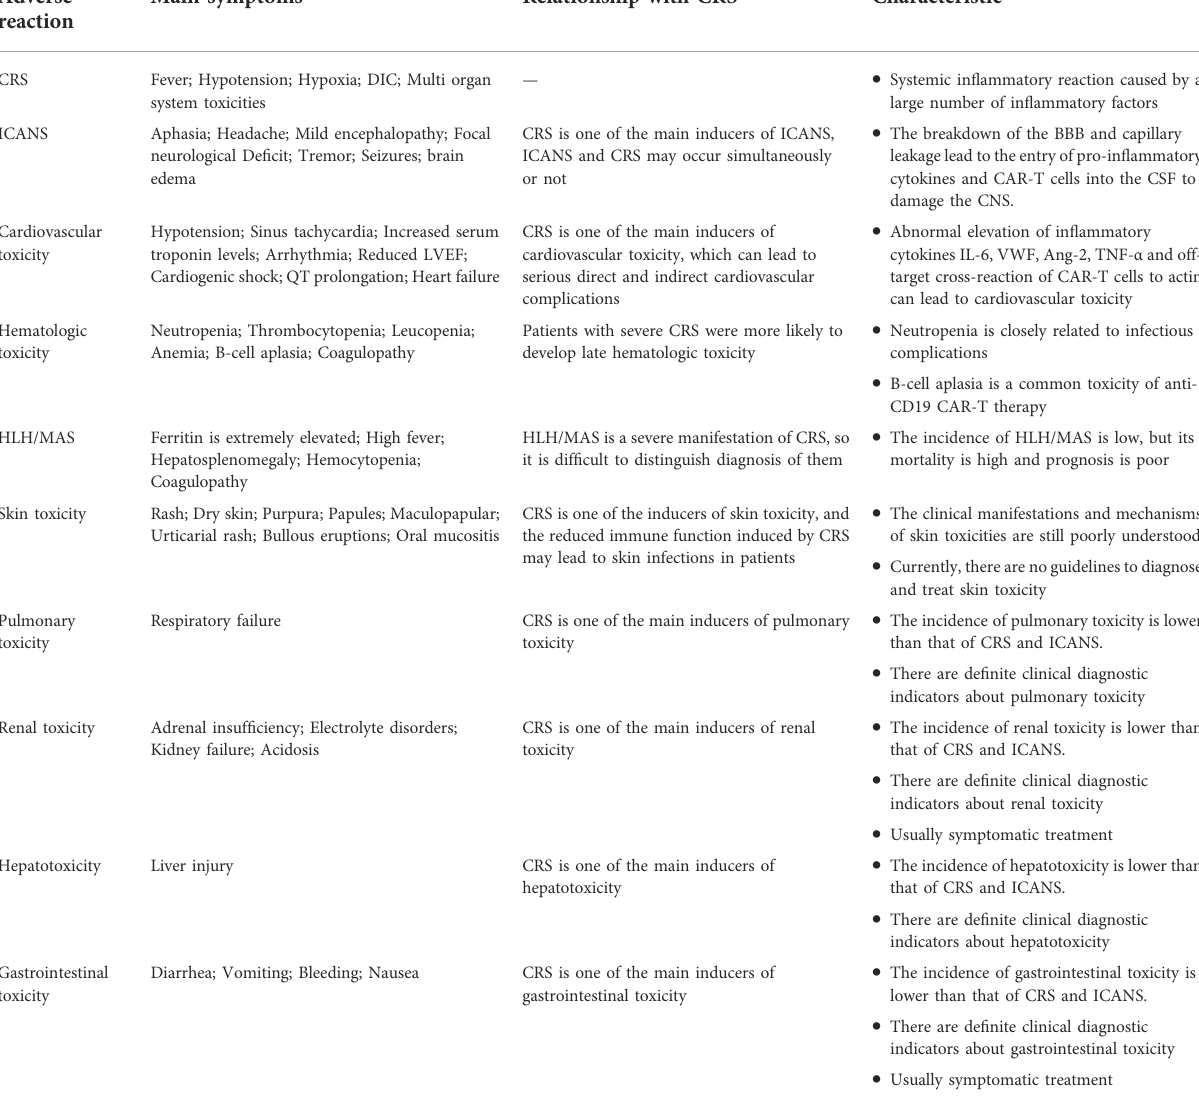
TABLE 2 Adverse reactions related to CAR-T cell